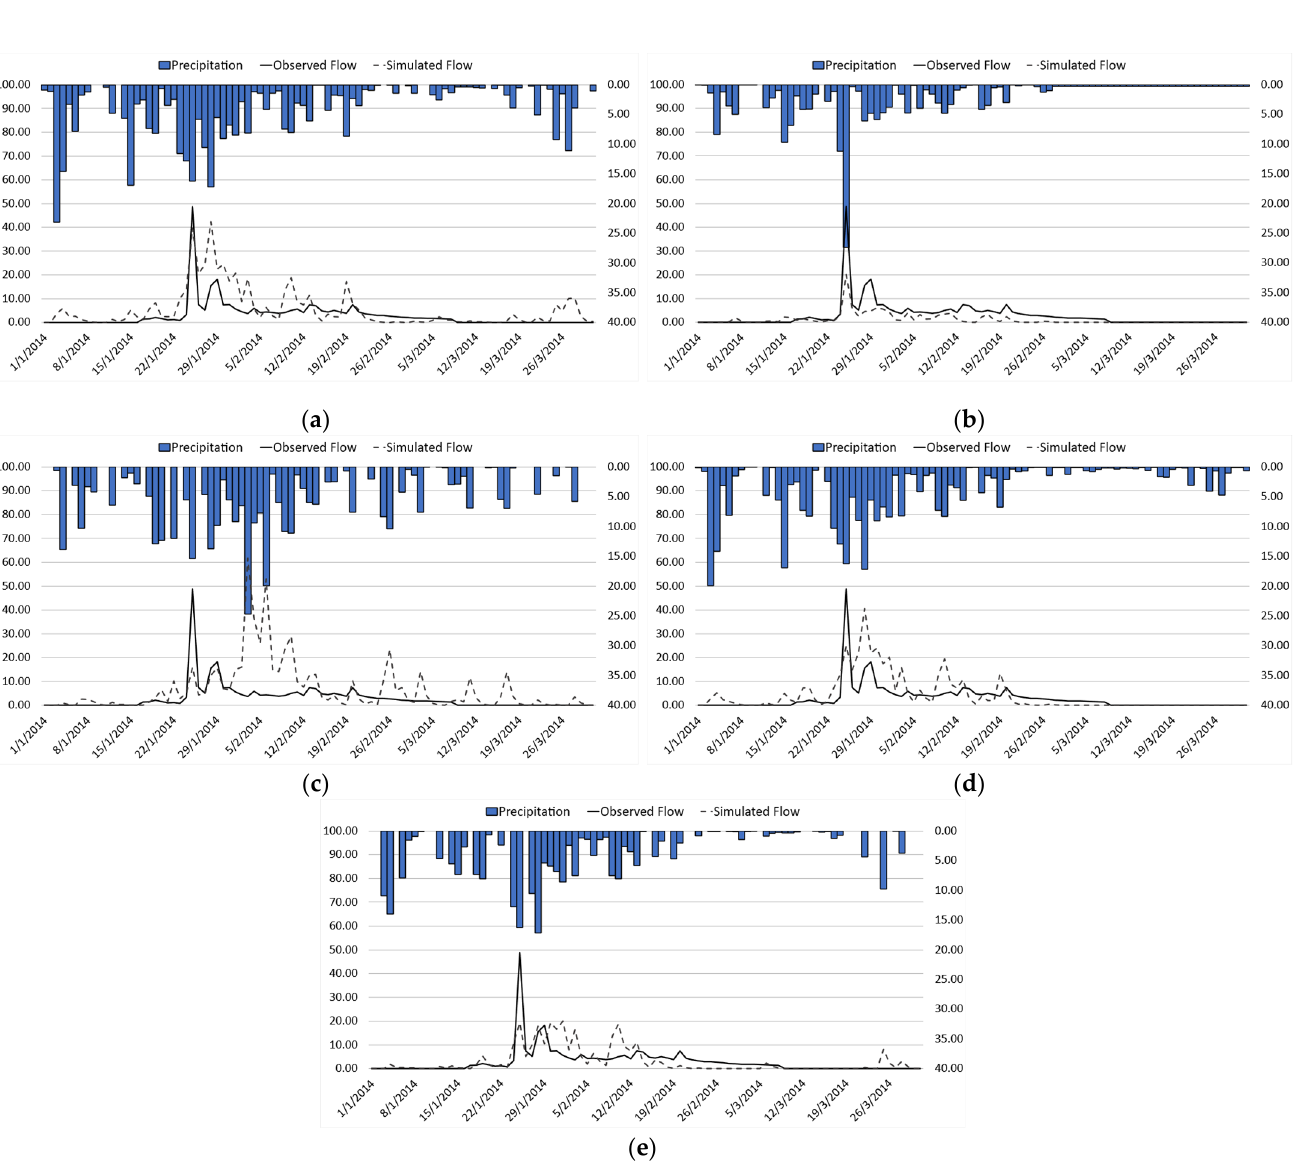
Figure 15. Precipitation time series of simulated and observed river discharge at Puente Cajon Station, using various products: ( a ) rain gauge, ( b ) GSMaP, ( c ) CHIRPS, ( d ) GS and ( e ) CH. The statistical indicators of simulated river discharge at Puente Cajón Station can be using the GS precipitation product compared to a rain gauge. Table 3. Statistical indicators of simulated river discharge at Puente Cajón Station. Rain Gauge